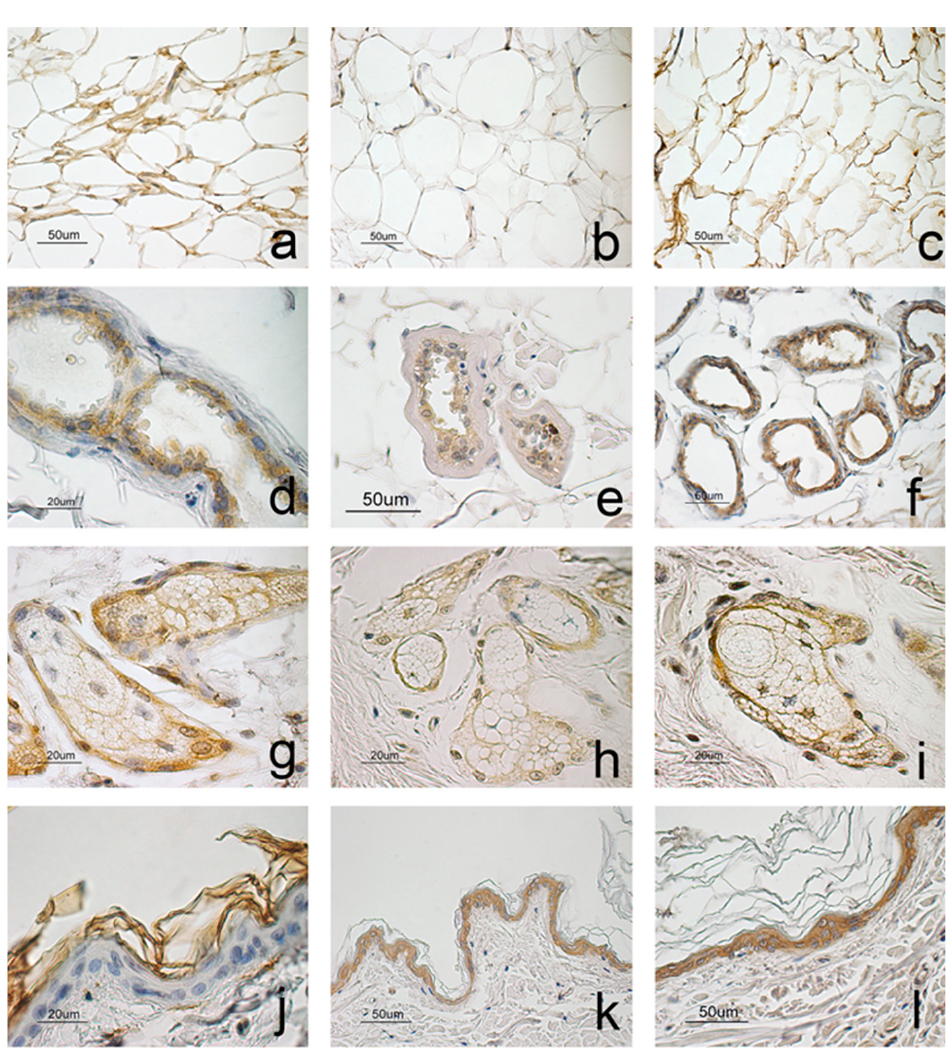
Figure 2. Immunostaining for ADIPOQ ( a , d , g , j ), ADIPOR1 ( b , e , h , k ), and ADIPOR2 ( c , f , i , l ). ADIPOQ ( a ) and ADIPOR2 ( c ) stained adipose tissue located among hair follicles that instead appeared negative to ADIPOR1 ( b ). In the sebaceous and sweat glands, positivity appeared stronger to ADIPQ ( d , g ) and ADIPOR2 ( f , i ) respect to ADIPOR1 ( e , h ). ADIPOQ ( j ) did not stain the epidermis while both receptors were observed in all epidermal cell layers ( k , l ).